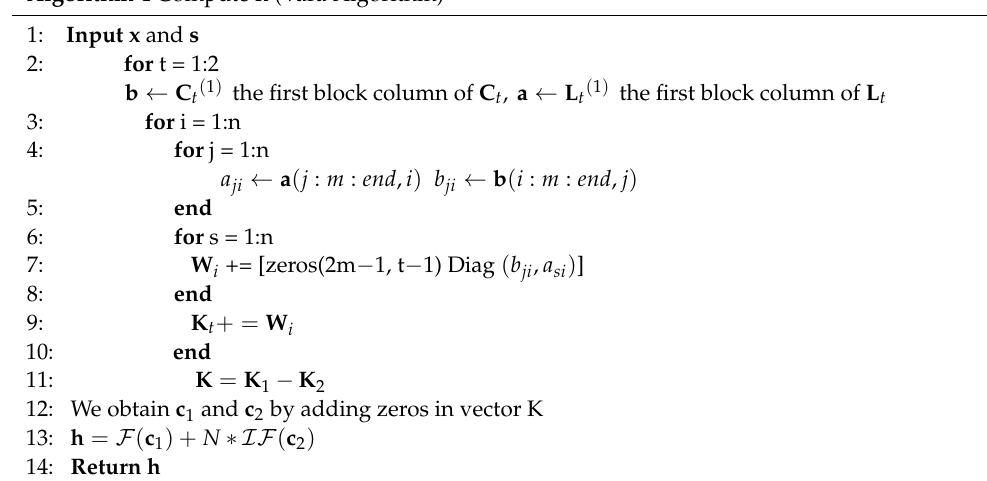
Algorithm 4 Compute h (Vara